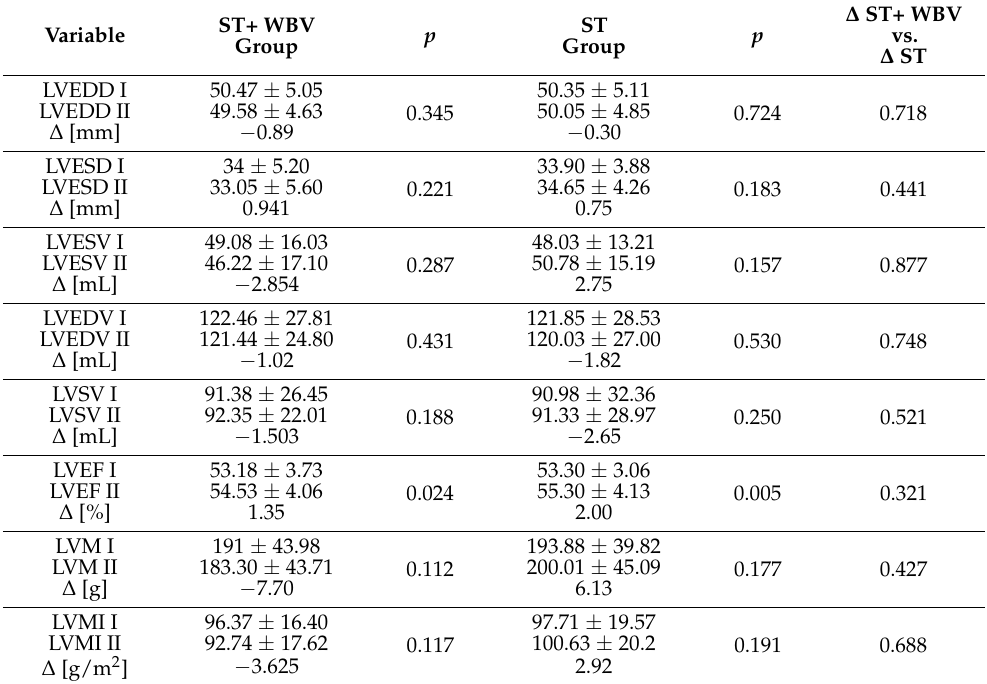
Table 4. Echocardiographic test results in both study